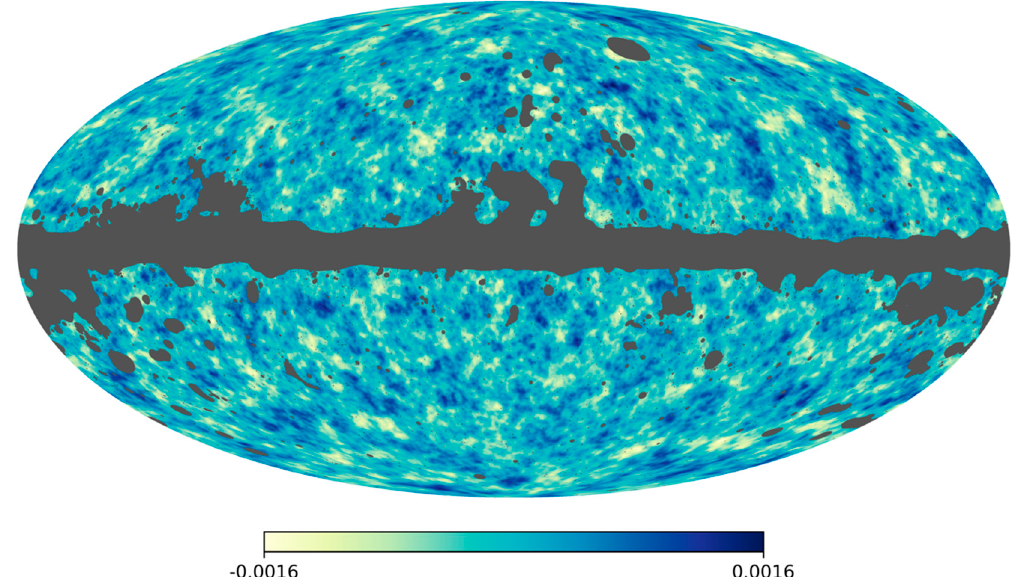
Figure 15. The 2018 Planck lensing deflection reconstruction derived from temperature and polarization maps. Dark blue areas represent regions that are denser than the surroundings, and bright areas represent less dense regions. The grey portions of the image correspond to patches of the sky where foreground emission, mainly from the Milky Way but also from nearby galaxies, is too bright, preventing cosmologists from fully exploiting the data in those areas. Image credit: ESA and the Planck Collaboration.